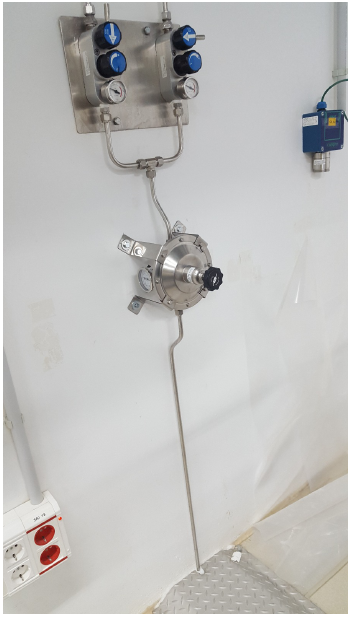
Figure 22. ATEKO-Air main line in Hall